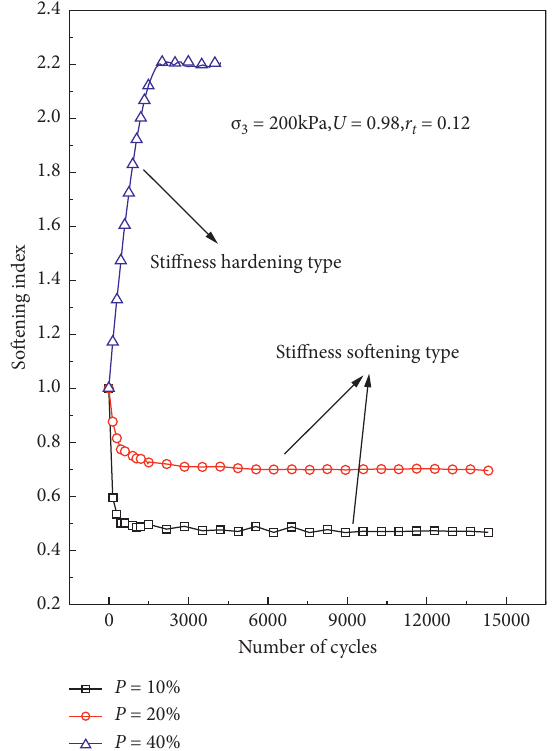
Figure 11: Rock content effect on the softening index of SRM.